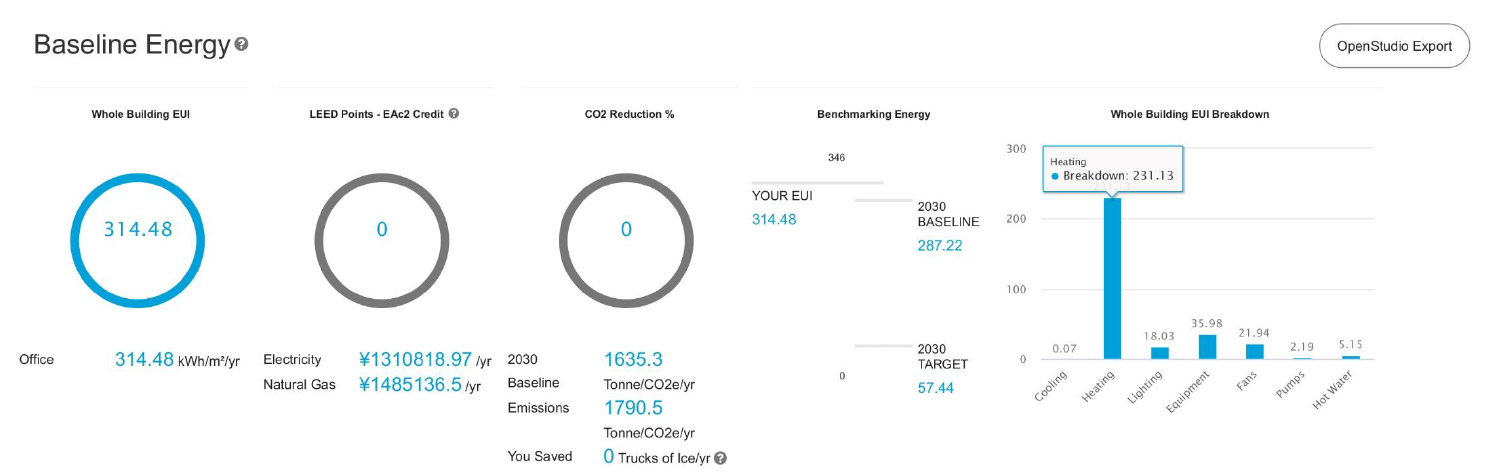
Figure A27. Zone 5-B Lanzhou, Gansu (post-COVID-19 84% scenario).